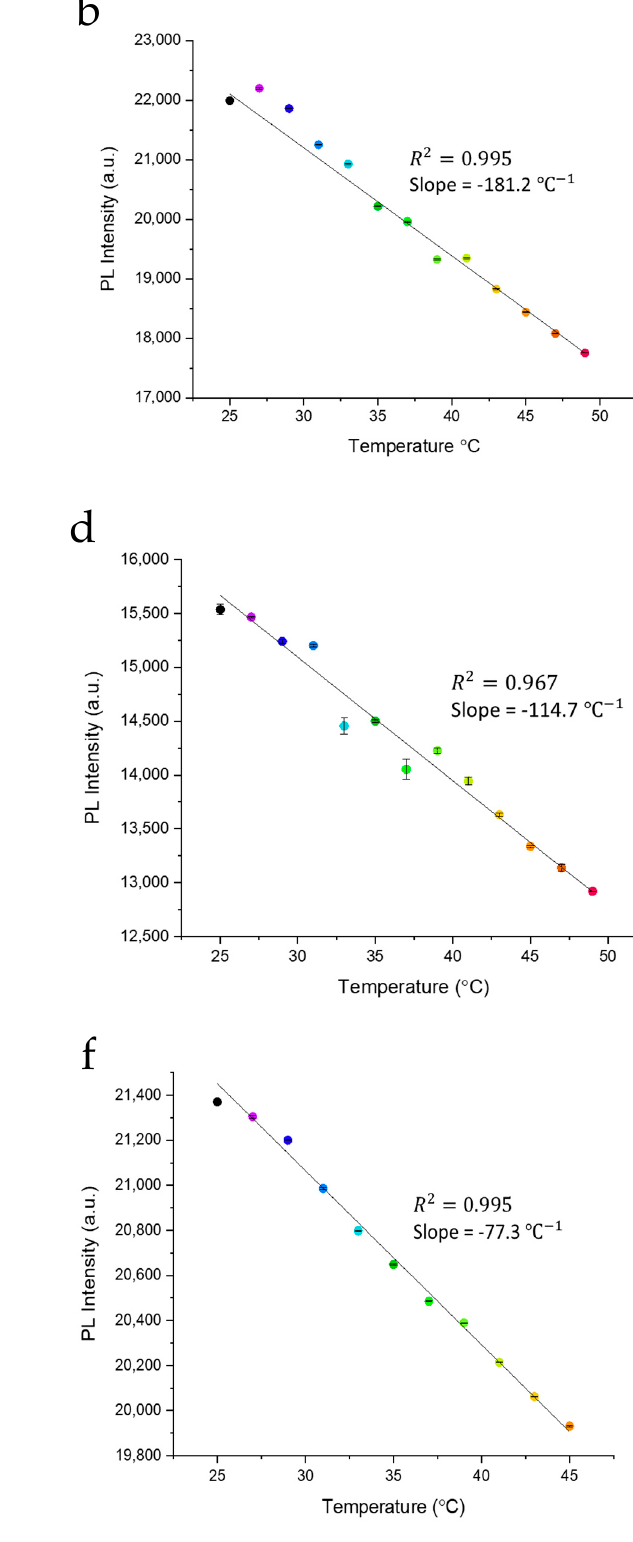
Figure 2. Fluorescence spectral evolution with temperature for ( a ) N-GQD visible emission, ( c ) RGQD visible emission, and ( e ) RGQD near-infrared emission. Linear decrease of peak fluorescence intensity with temperature for ( b ) N-GQD visible emission, ( d ) RGQD visible emission, and ( f ) RGQD near-infrared emission.